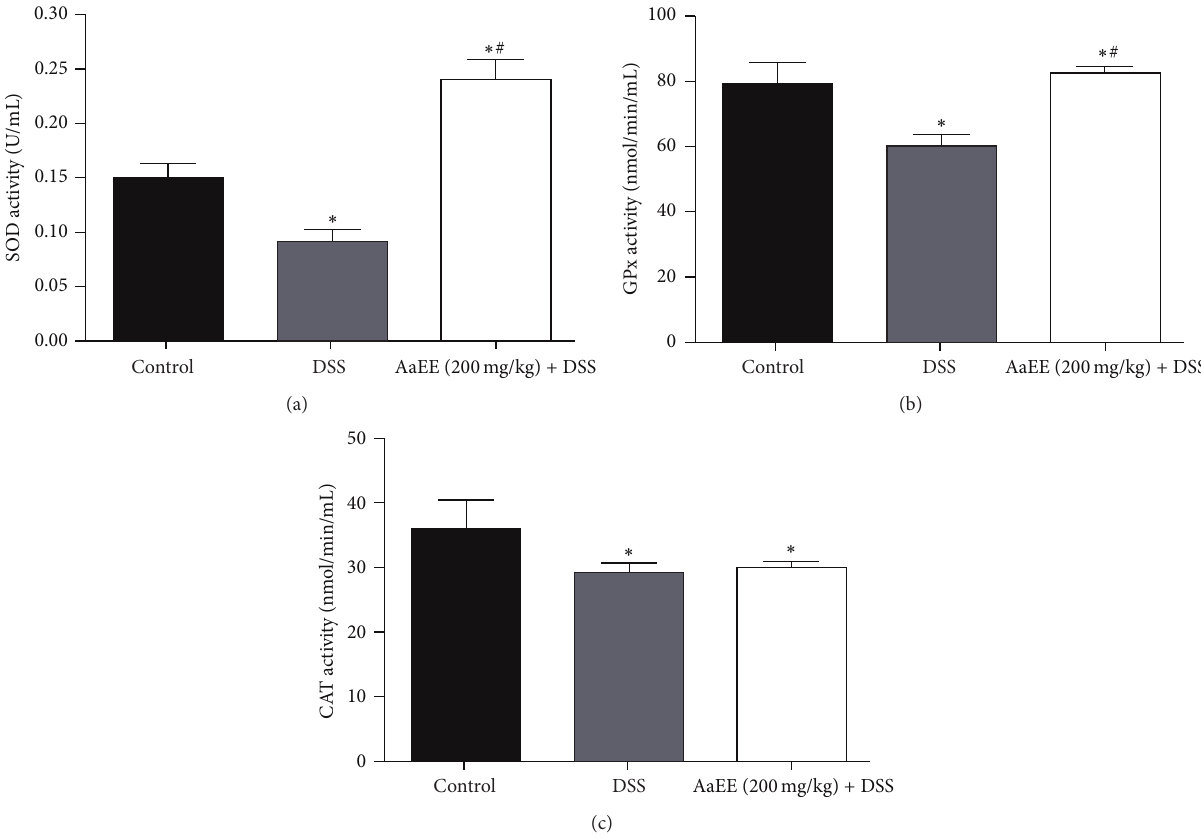
Figure 4: Protection of AaEE against oxidative stress in colorectums during ulcerative colitis induced by DSS in mice. SOD activity (a), GPx activity (b), and CAT activity (c). Data represents as mean ± SD ( 𝑛 = 6 ), ∗ 𝑃 < 0.05 versus control group; # 𝑃 < 0.05 versus DSS group.